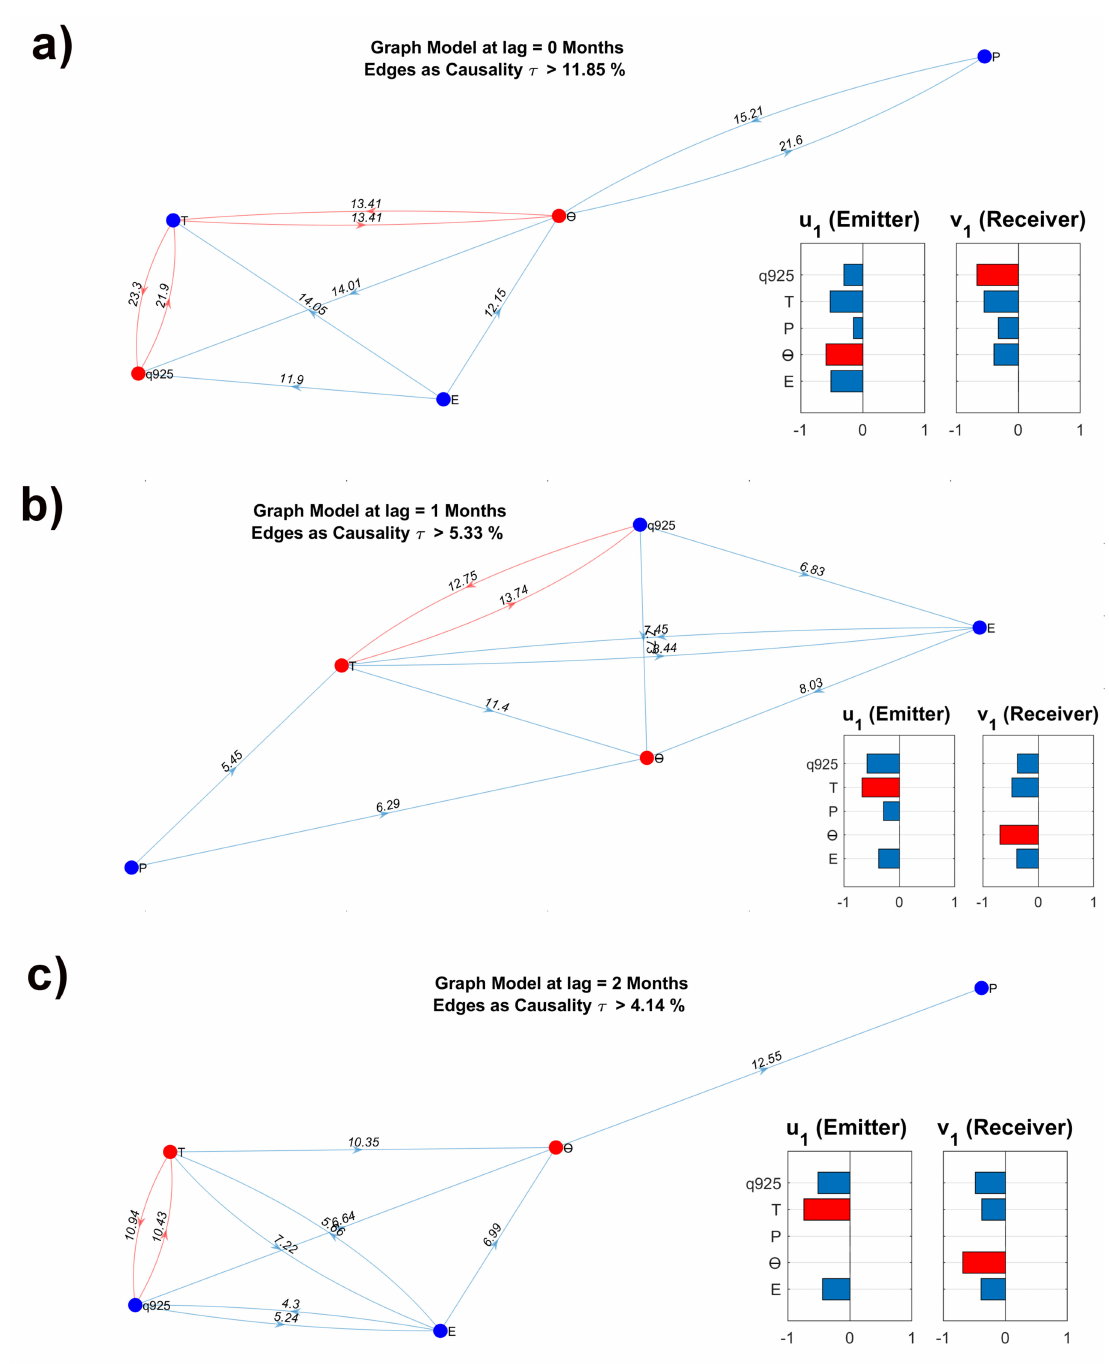
Figure 7. Causality Graphs constructed with the highest ENSO-related mode time series from each pairwise of variables. The weights of the edges between the nodes are estimated as the simultaneous (cid:12) (cid:12) (cid:12) (cid:12) causality ( (cid:12) τ x ←→ y (cid:12) and (cid:12) τ y ←→ x (cid:12) ) between the MCA-series. Red edges represent feedbacks between variables. Bar panel represents leading singular vectors u 1 and v 1 estimated from the the adjacency matrix; ( a ) Simultaneous (No Lags); ( b ) one-month lag; ( c ) two-month